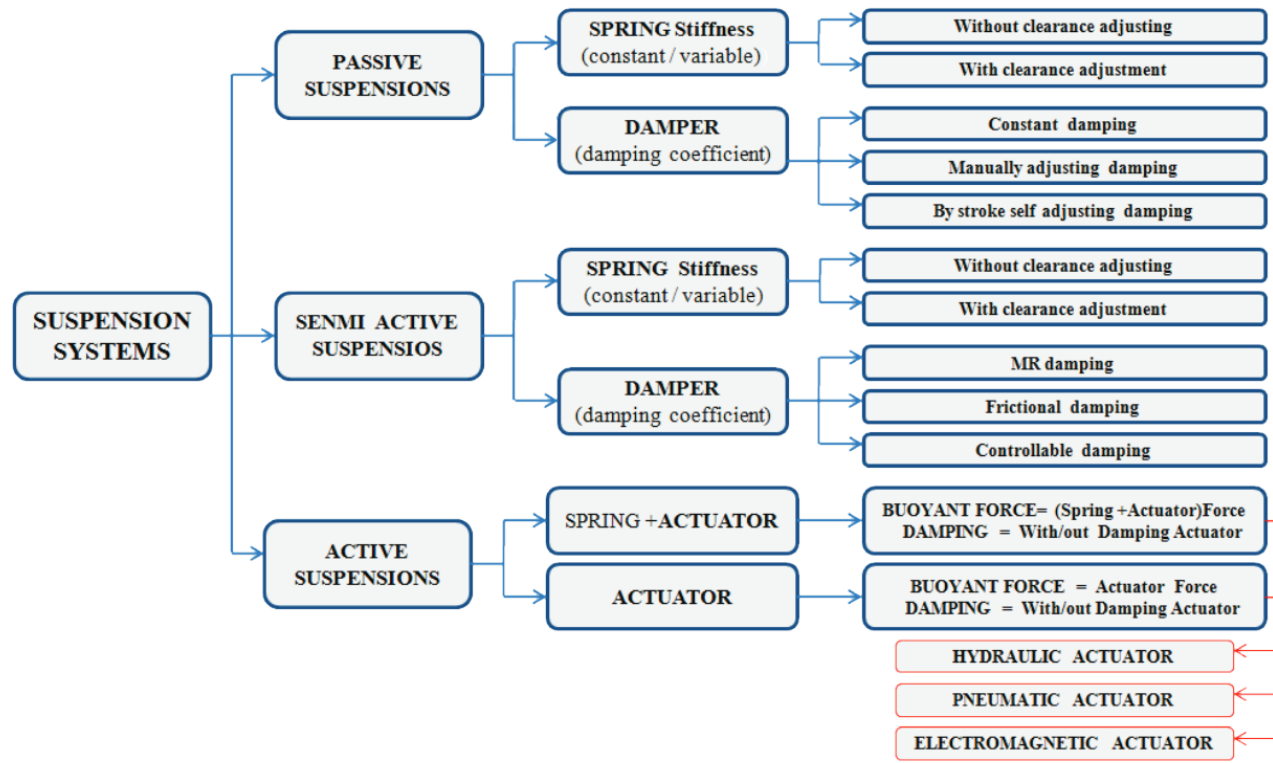
Figure 1. Classification of automotive suspension systems. Adapted from Figure 1 . Classification of automotive suspension systems. Adapted from [9].